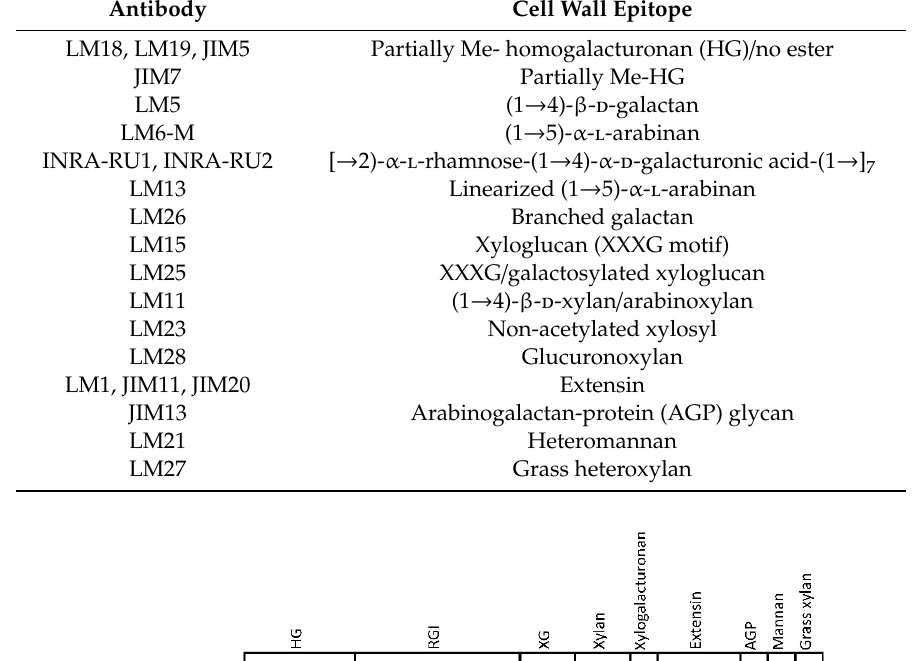
Table 1. List of monoclonal antibodies used in the carbohydrate microarray and the epitopes recognized by each mAb.